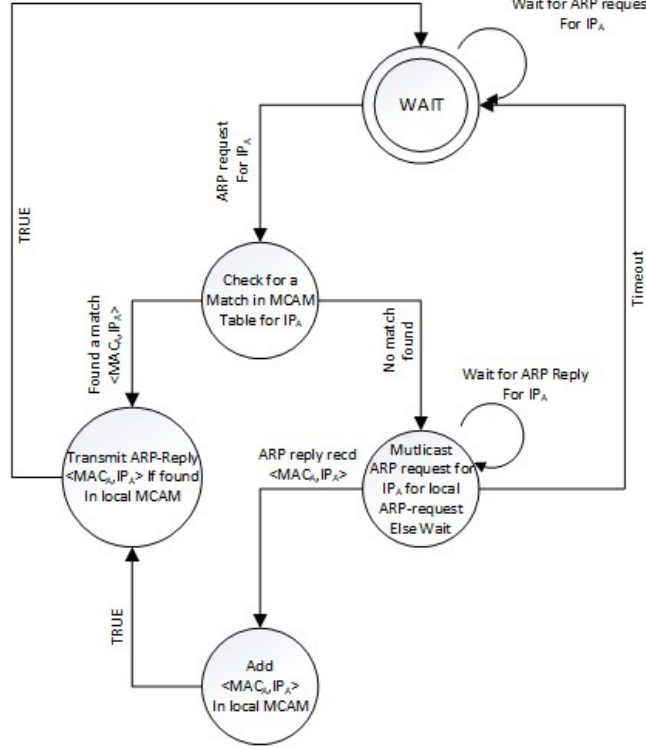
Figure 4. Protocol for Eliminating Broadcast (PrECast) ARP-lookup